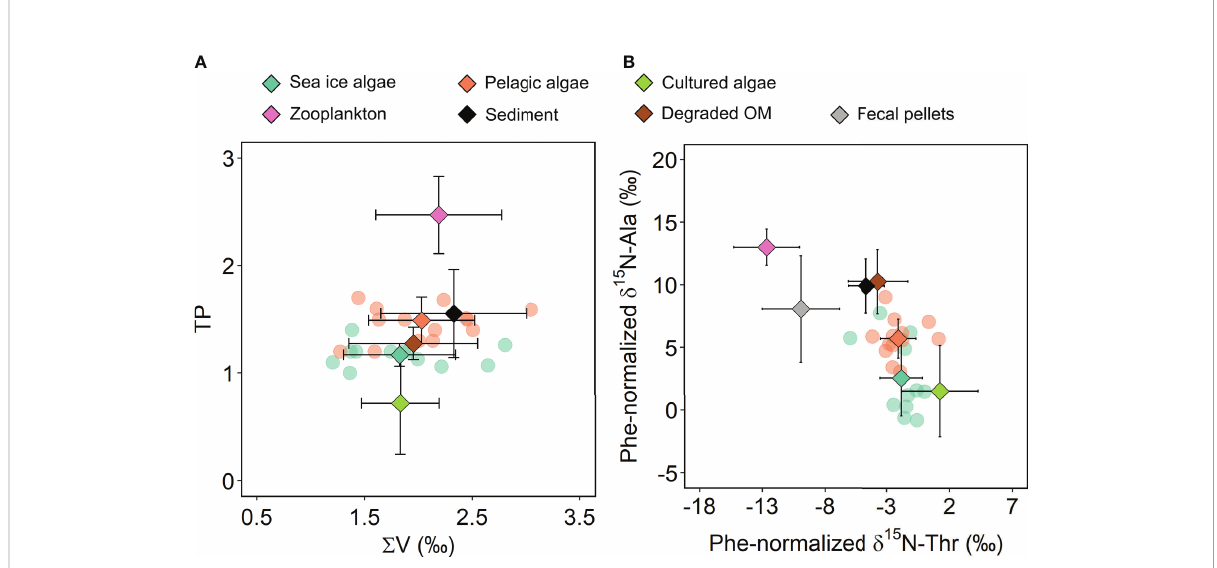
FIGURE 6 Estimation of trophic transfers and microbial reworking from d 15 N-AA. (A) End-member trophic position (TP) and the ∑ V parameter of sea ice (brash-ice) and pelagic algae were calculated based on calibrated d 15 N-AA values (semi-transparent circles) with end-member means and ±1 standard deviations (diamonds with error bars). (B) End-member data based on Phe-normalized d 15 N of Ala and Thr (semi-transparent circles) are shown with end-member means and ±1 standard deviations (diamonds with error bars). Other end-member means and standard deviations are shown in diamonds with error bars from previously published studies: cultured algae, McCarthy et al., 2013; sediment, Sauthoff, 2016; degraded OM, Yamaguchi and McCarthy, 2018; fecal pellet and zooplankton, Doherty et al., 2021). OM, organic